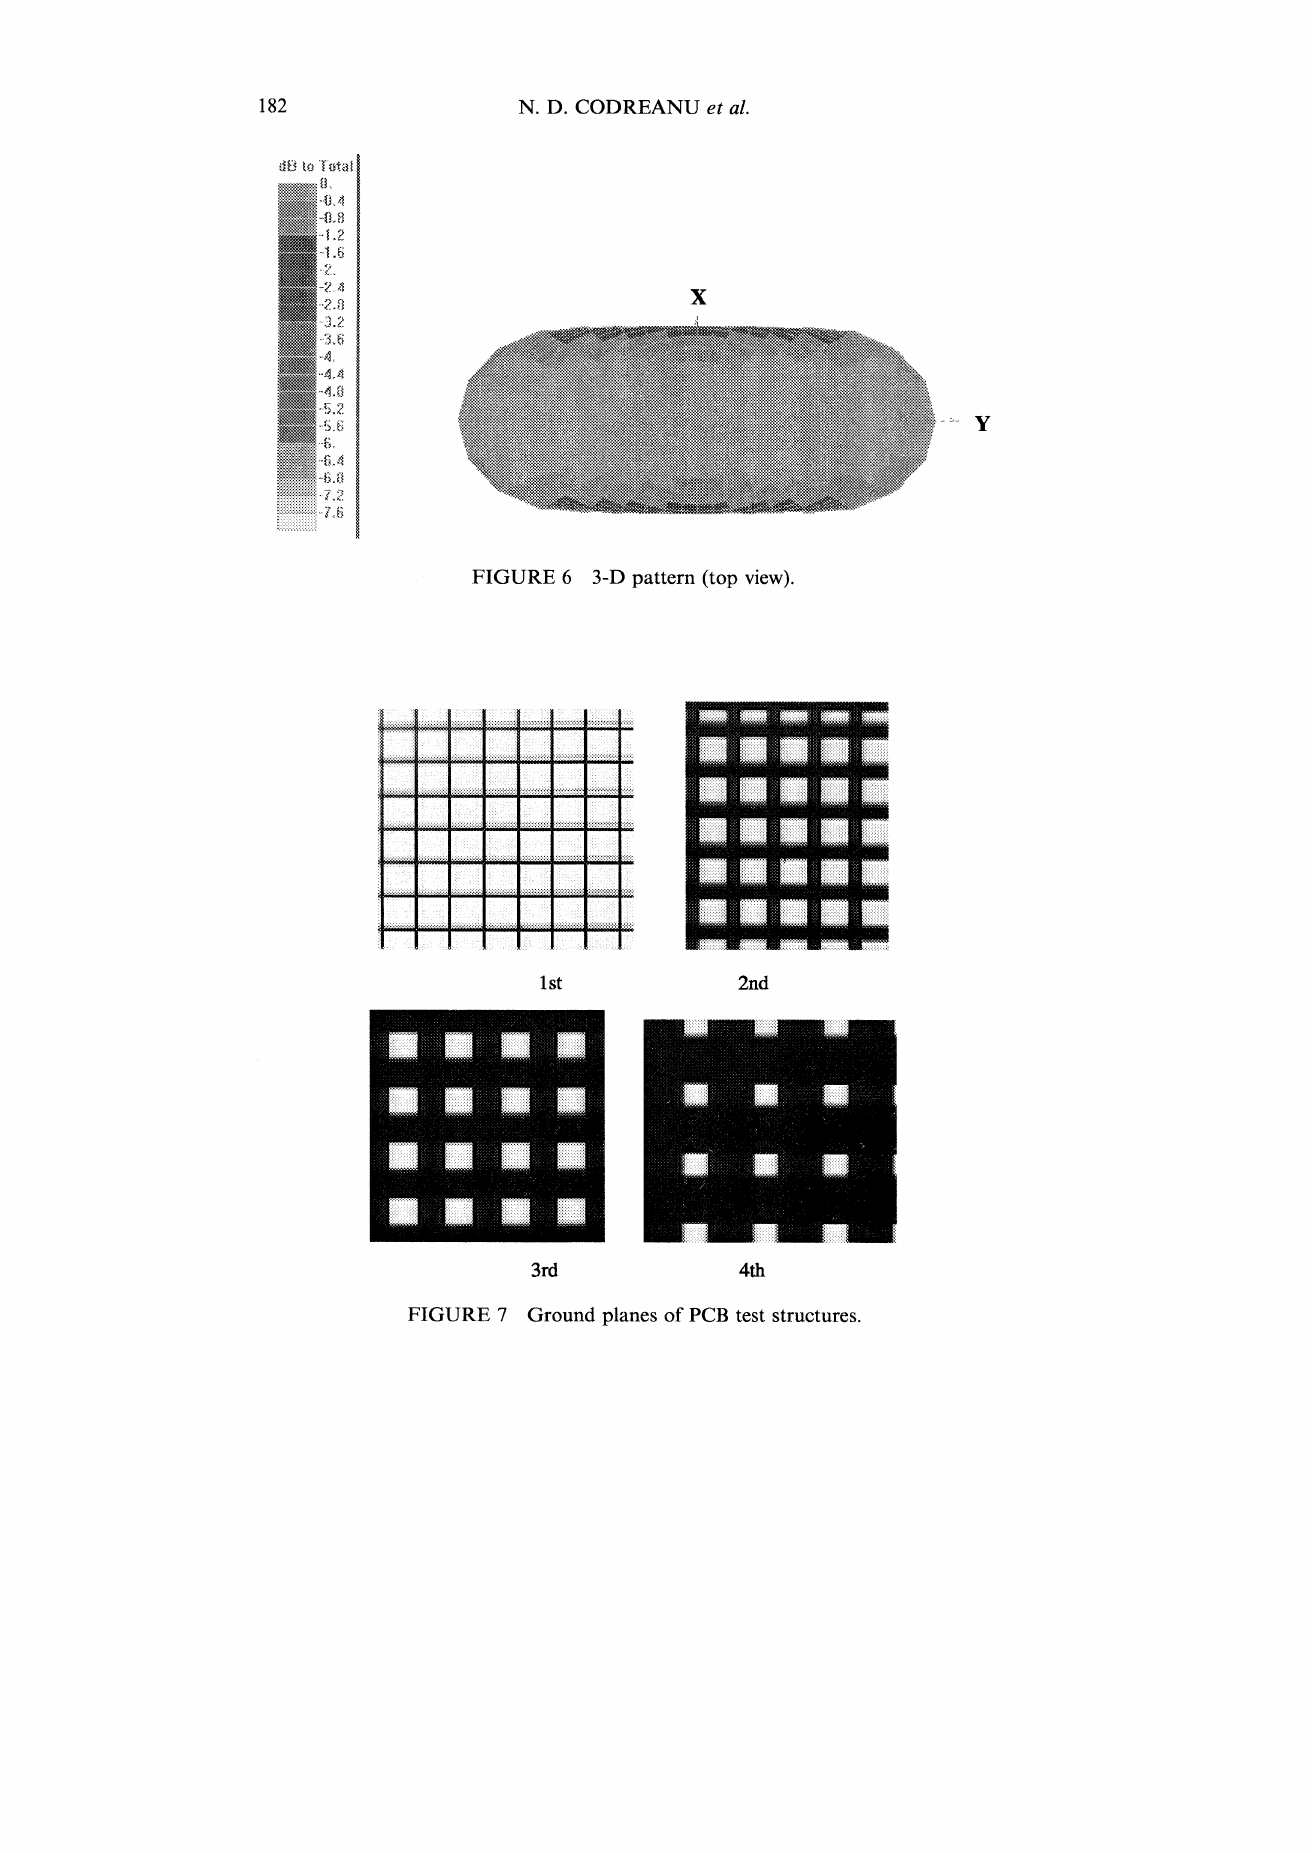
FIGURE 7 Ground planes of PCB test